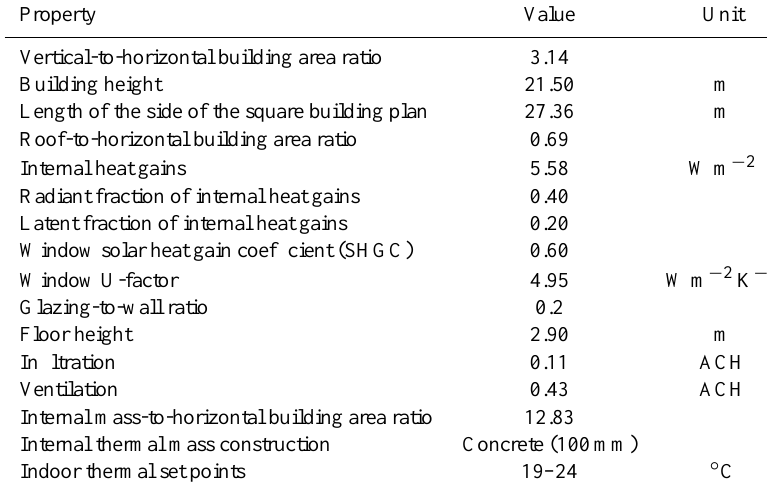
Table 1. Simulation parameters used in the comparison between the simplified EnergyPlus model and the detailed EnergyPlus model of a Haussmannian building. Property values represent a typical residential building.